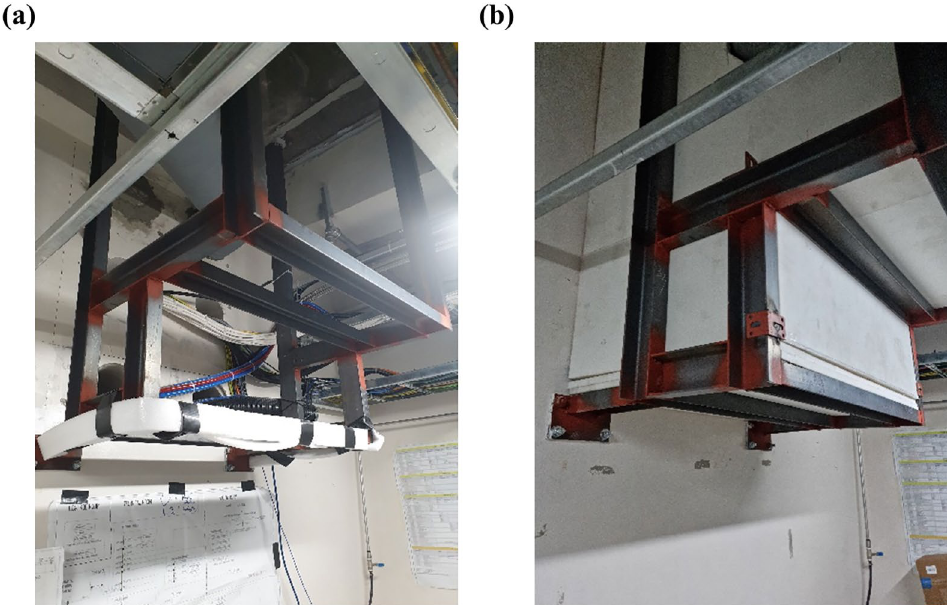
Figure 4. Comparison ( a ) before and ( b ) after the special shielding design to reduce leakage dose around the